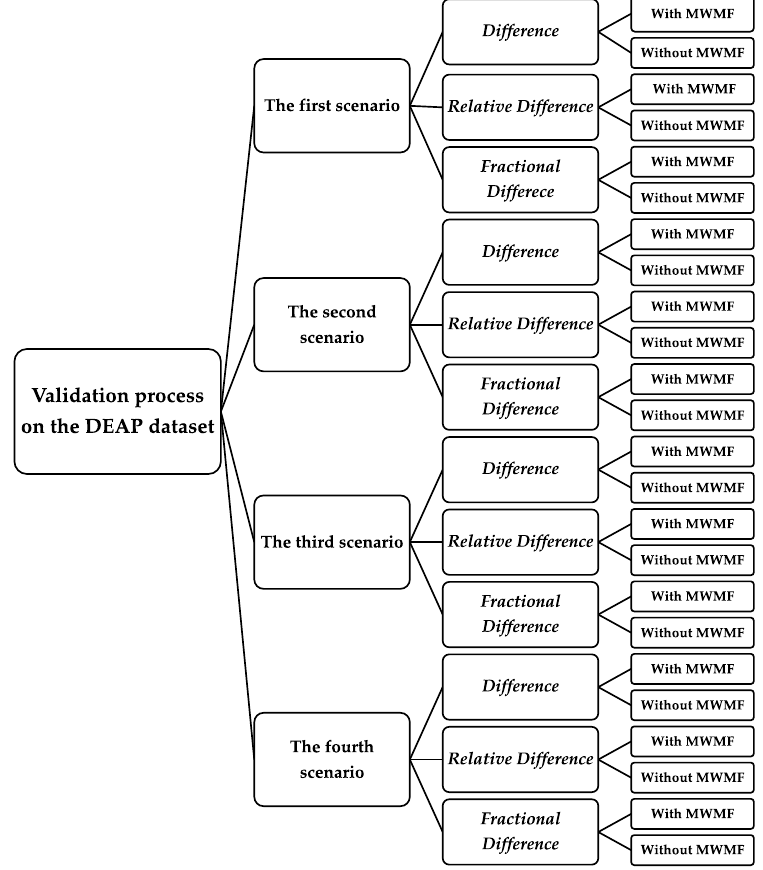
Figure 9. Twenty-four validation procedures were performed for each